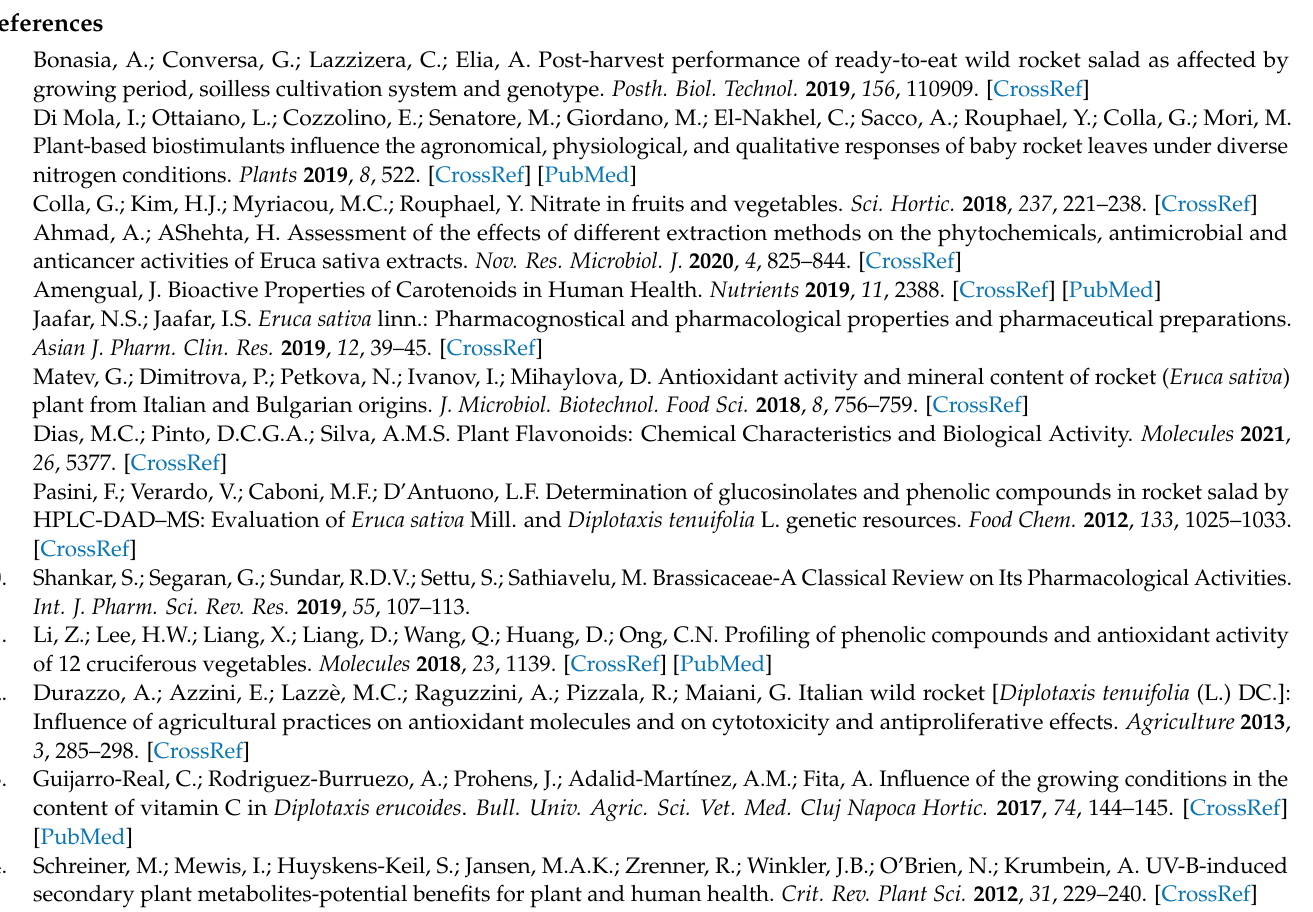
chromatogram of standard of quercetin; Figure S4: HPLC chromatogram of standard of rutin; Figure S5: HPLC chromatogram of standard of caffeic acid; Figure S6: HPLC chromatogram of standard of gallic acid; Figure S7: Typical HPLC chromatogram of sample of rocket